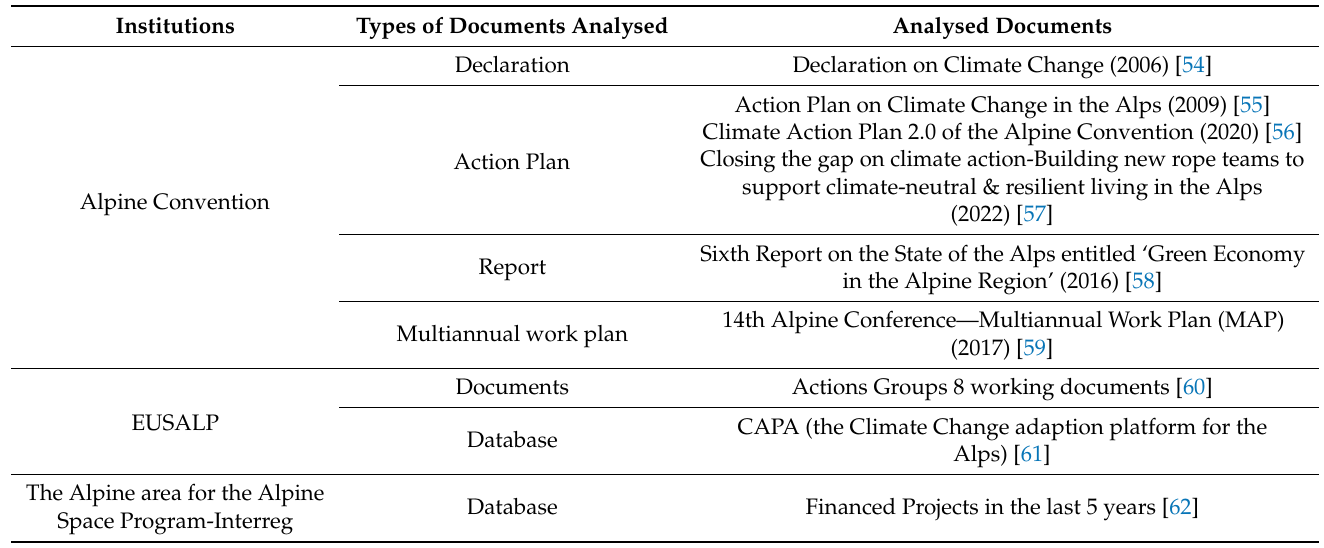
Table 1. List of documents formulated at the European level for the entire Alpine regions considered in the present study.